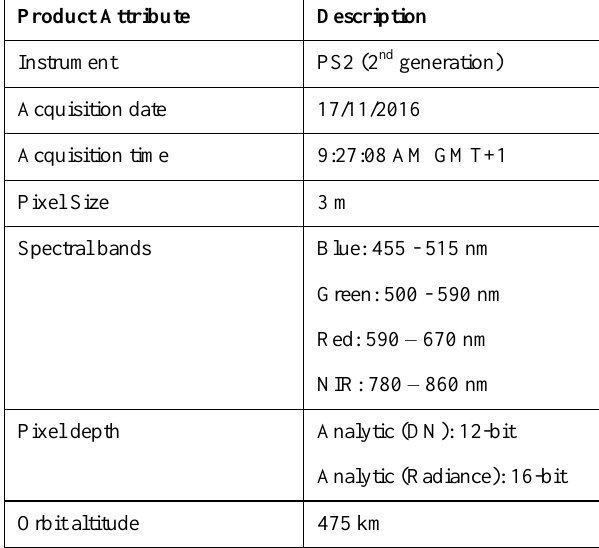
Table 1. PlanetScope Analytic Ortho Scene Product